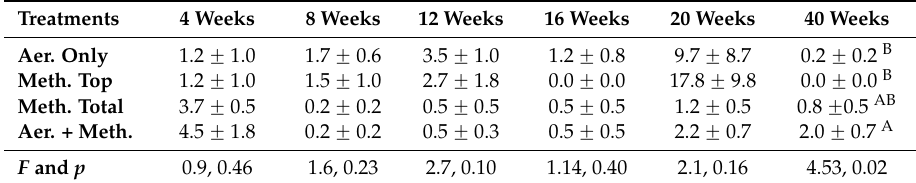
Table 3. Mean numbers ( ˘ SE) of adult R.dominica captured by probe traps at different times after bins were loaded with wheat that was either treated with aeration only, the top 50 cm-treated with methoprene, methoprene treatment to all the wheat in a bin, or aeration plus complete treatment with methoprene on all grain in the bin. Means within columns with the same upper case letter, for which there was a significant ( p < 0.05) F-statistic, are not significantly different(LSD test, p < 0.05, SAS Institute, degrees of freedom for analysis within date for treatment were 3, 12).